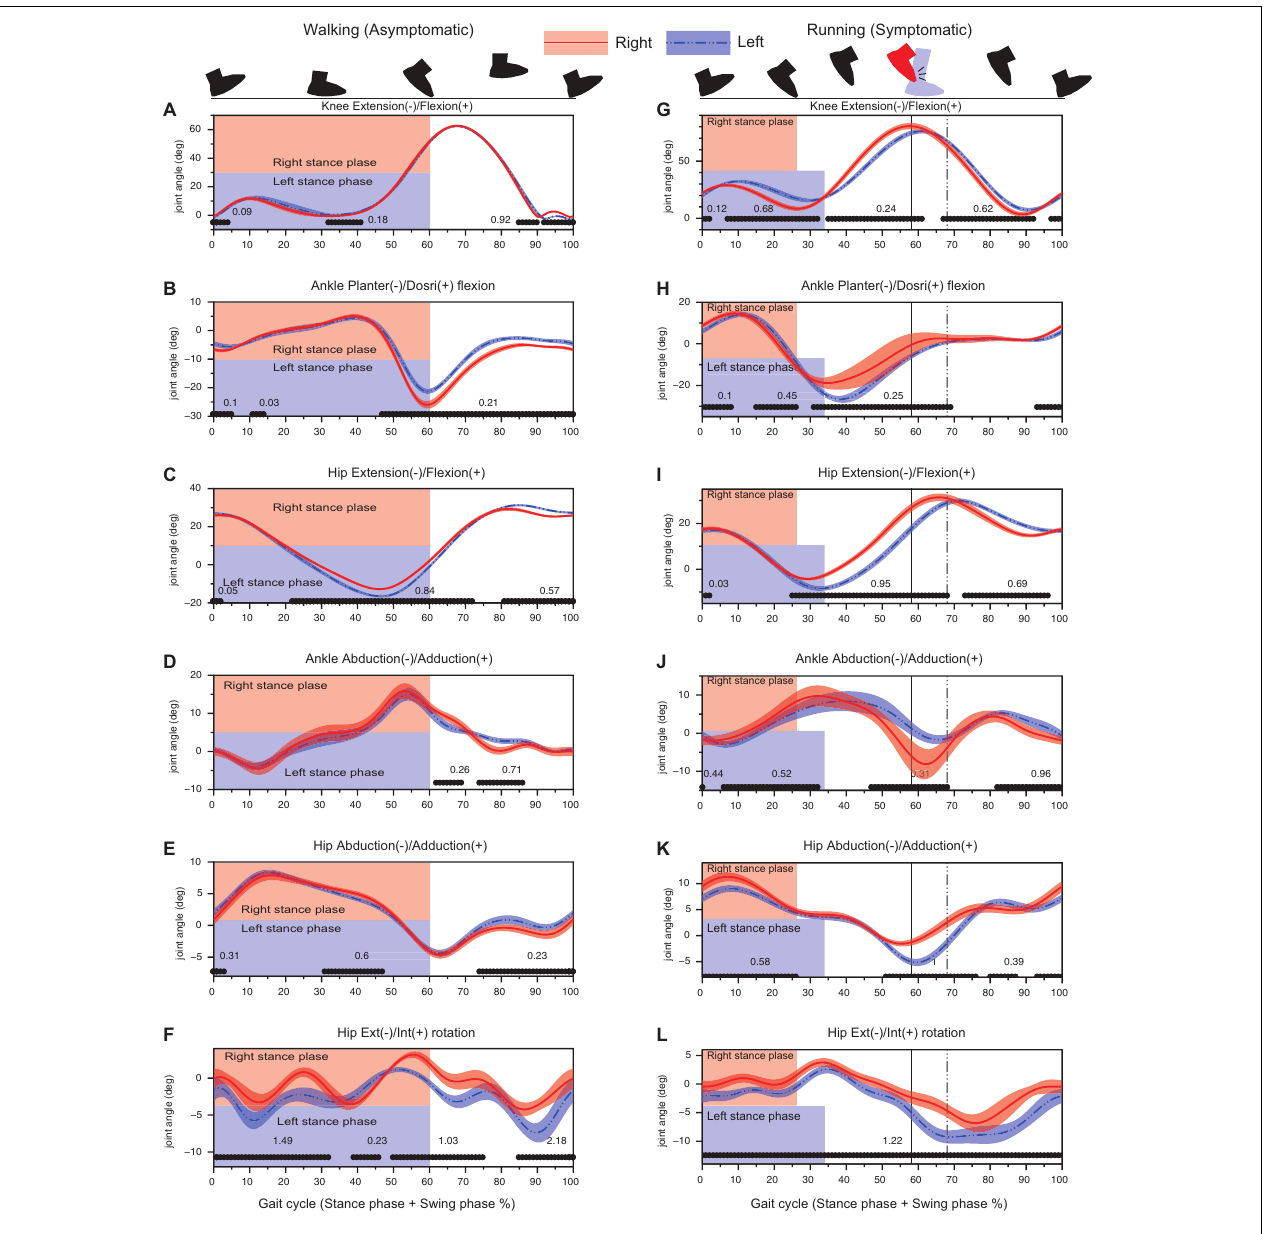
FIGURE 4 | Results of kinematic analysis during walking (left column) and running (right column) assessed by 1D SPM. Black lines with the Cohen’s d -value at the horizontal axis of each panel showed significant difference between the right and left legs. Vertical lines denote the timing of foot collision for right leg (solid line) and for left leg (dashed line). Note that the percentage of the stance-phase and the foot collision time was different between the right and left legs in 100% gait cycle representation since the absolute stance-phase duration was significantly different between limbs (as shown in Figure 3